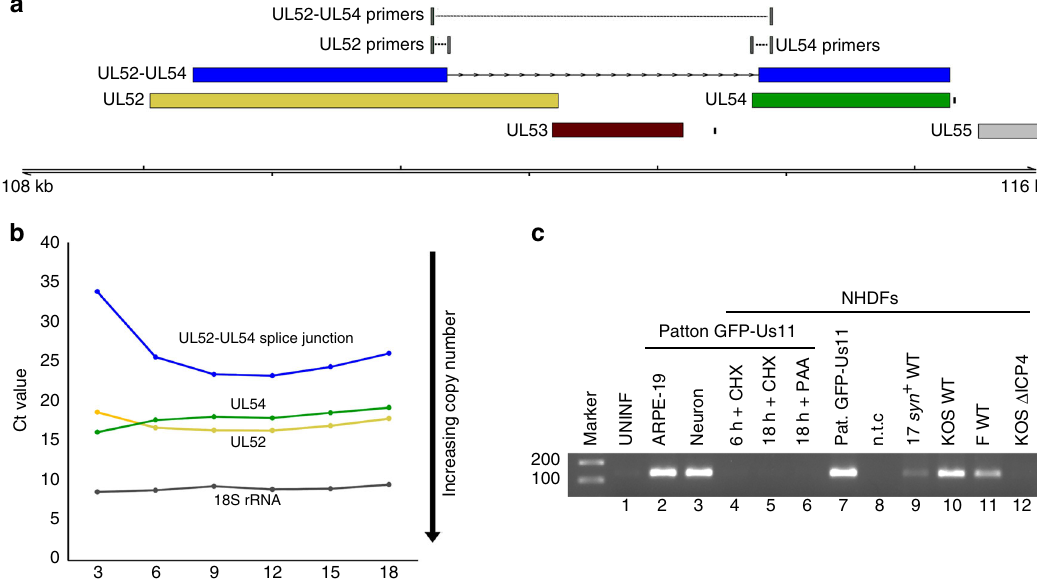
Fig. 6 Chimeric UL52 – UL54 mRNA is expressed with late kinetics and by multiple HSV-1 strains. a The UL52 – UL54 fusion transcript. b Assessment of the UL52 – UL54 splice junction usage at different times after infection by real-time RT-qPCR. Increased RNA abundance is re fl ected as lower crossover threshold (Ct) values and normalized to 18S rRNA. Three technical replicates were utilized per condition/time point. Representative data are shown from one of three biological replicates. c Detection of the unique UL52 – UL54 splice junction by RT-PCR using a primer scanning the splice junction. NHDFs were infected in parallel with either HSV-1 strain Patton (lanes 2 – 7) or with wild-type strain 17 syn + (lane 9), KOS (lane 10), strain F (lane 11) viruses, or with n12, a KOS ICP4 null mutant (lane 12), and RNA was collected at either 6 h (lane 4) or 18 h (lanes 2 – 3, 5 – 7, and 8 – 12) post infection. Inhibitors of